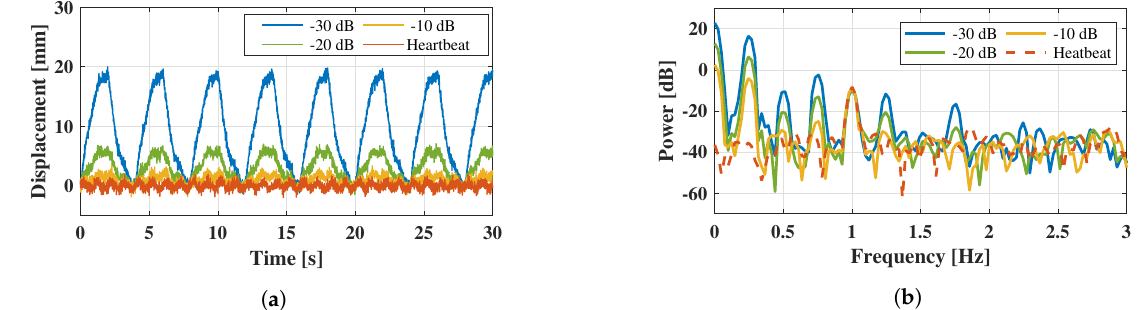
Figure 4. Vibration of the chest surface obtained by simulation: ( a ) shows the signal in the time domain and ( b ) indicates the spectrum by Fourier transform.